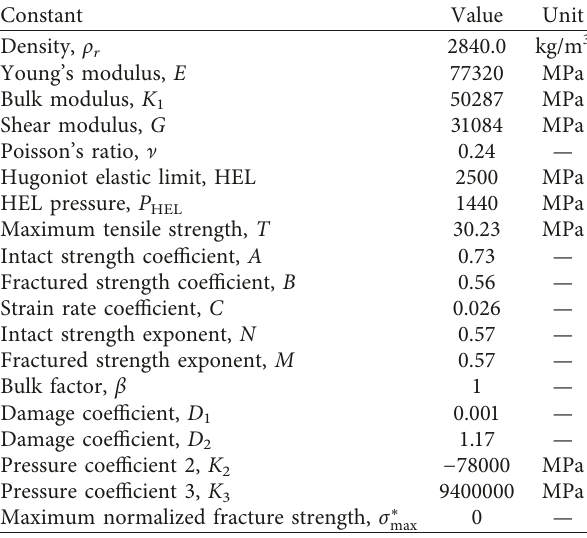
Table 1: Material properties for HE with EOS [25]. Table 2: Material properties for JH-2 material for